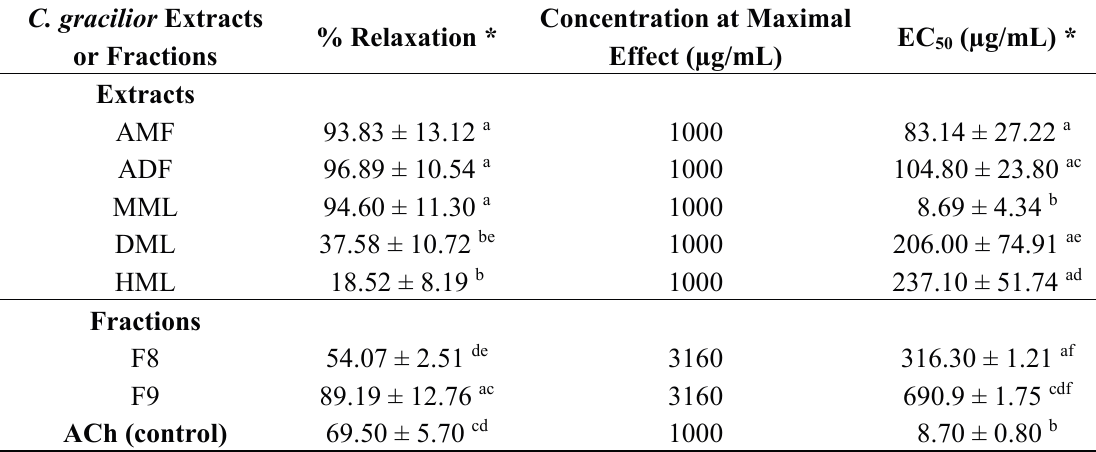
Table 1. Vasorelaxant effects induced by the extracts and some fractions of C. gracilior on the rat aortic rings precontracted with PE (1